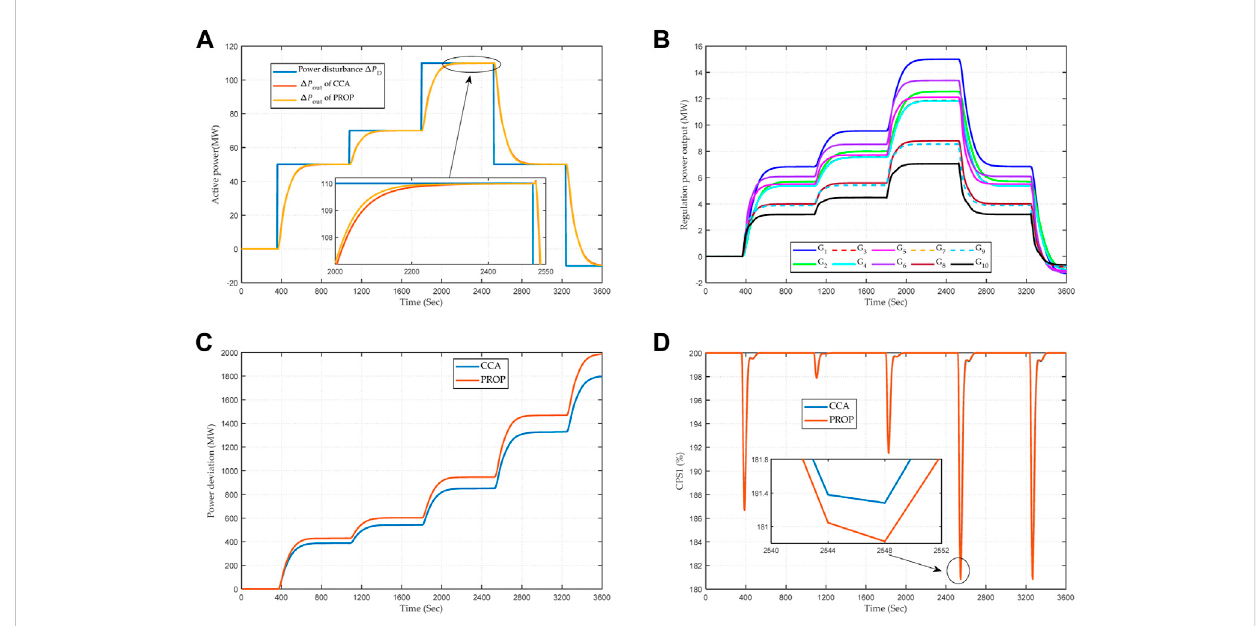
FIGURE 9 Dynamic power tracking scheme acquired by the proposed CCA and PROP for a stochastic power disturbance. (A) Power tracking curve. (B) Regulation resource output curves obtained by the proposed CCA. (C) Dynamic power deviation. (D) Dynamic CPS.